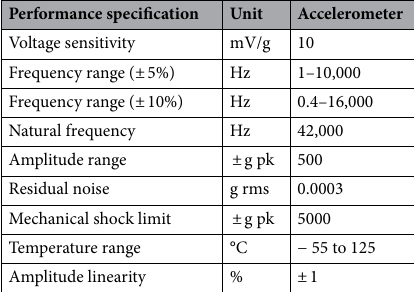
Table 3. Parameters of the accelerometer.